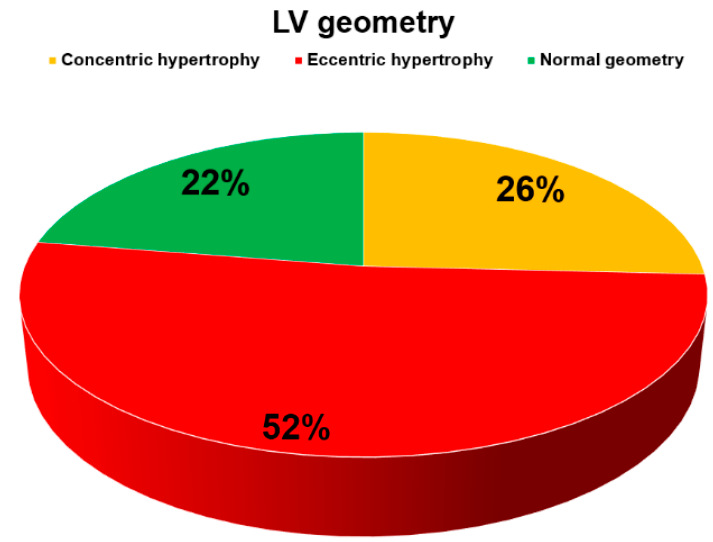
Figure 4. The distribution of left ventricular (LV) geometries as estimated by the relative wall thickness.